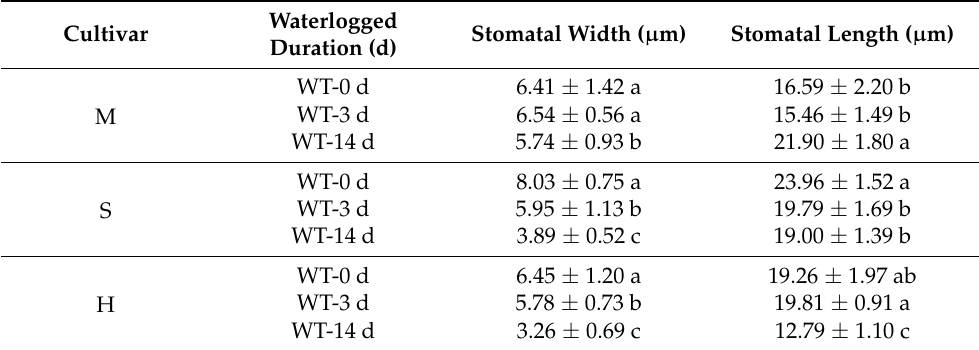
Table 2. Comparison of leaf stomatal morphological changes of different peach rootstocks under waterlogging stress.